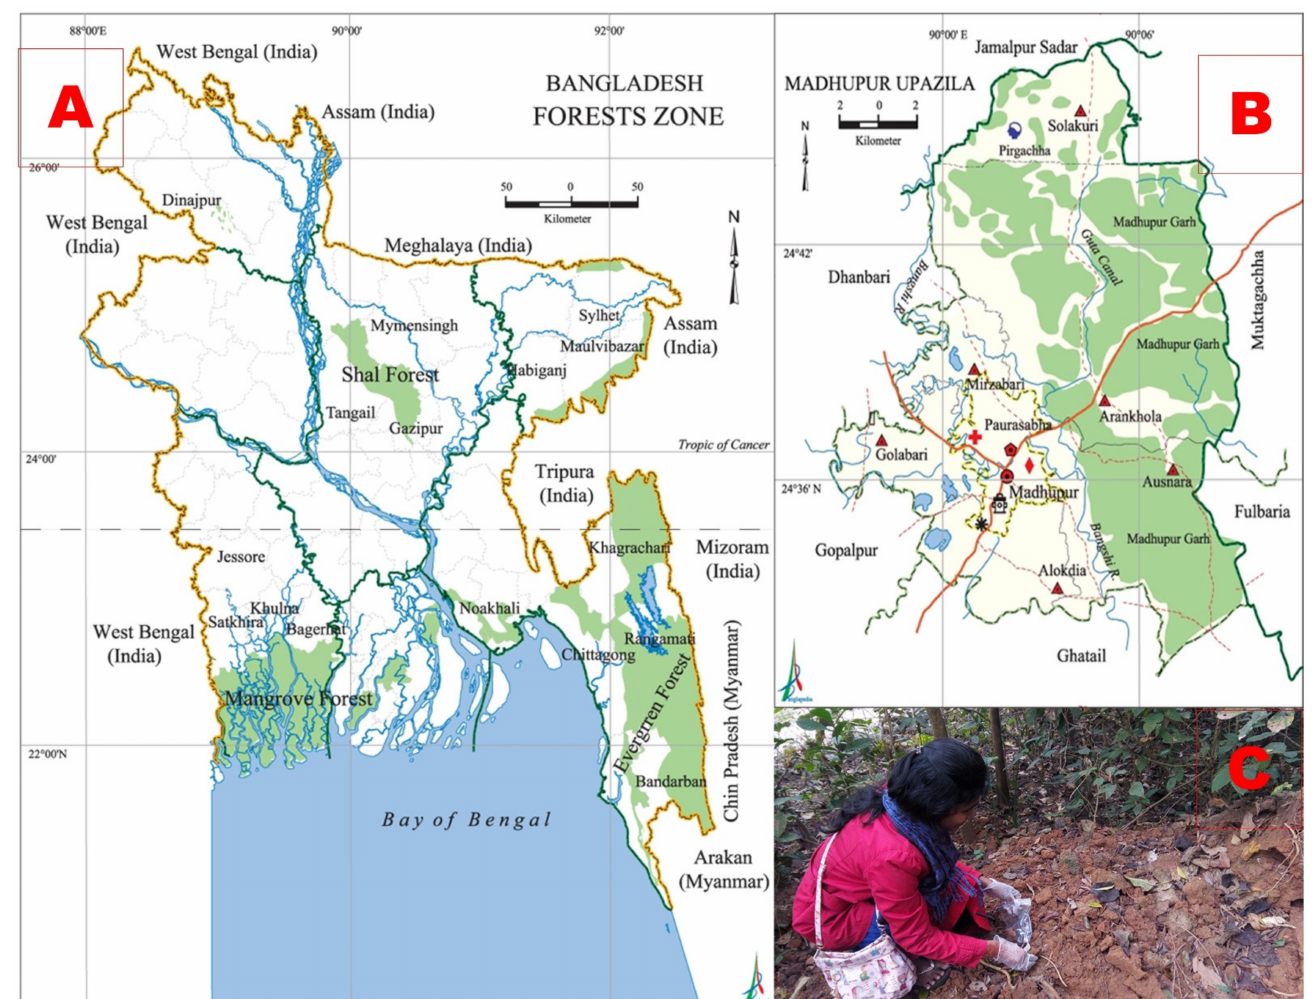
Figure 1. Pictorial view of sampling area (( A ): map showing Bangladesh; ( B ): map showing Madhupur National Park; ( C ): sampling). Courtesy of http://en.banglapedia.org/index.php/Forest_and_Forestry (Accessed on 1 May